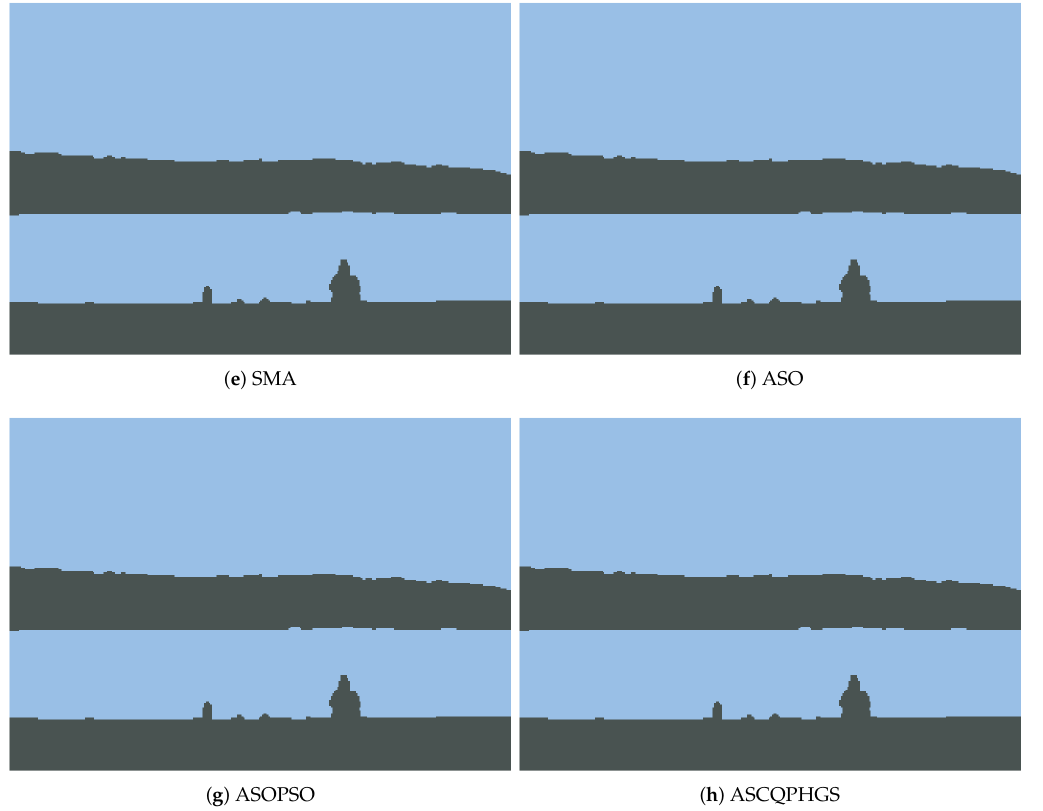
Figure 6. Segmentation of image I 1 BSD from BSD datasets using the competitive